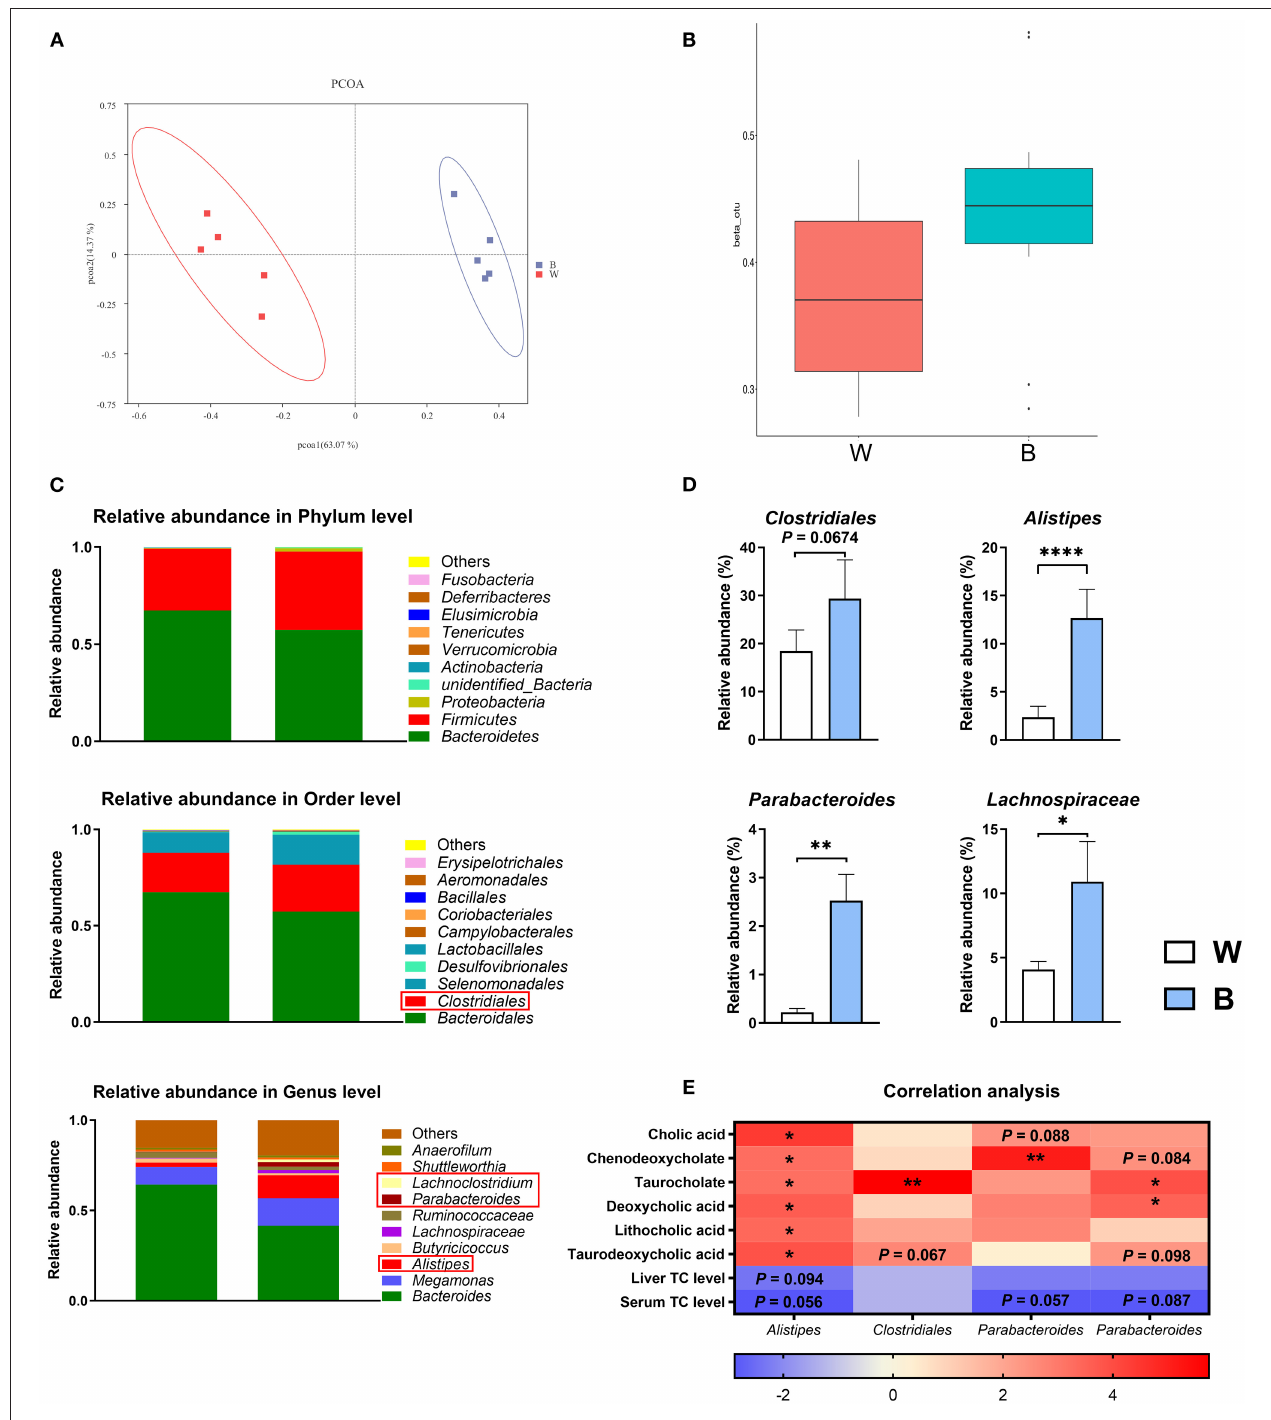
FIGURE 6 | Exposure to blue light alters the intestinal microbiota. (A) Principal component analysis of microbial communities in the cecum from the white-light and blue-light groups ( n = 6). (B) Beta diversity of microbial communities from the white-light and blue-light groups ( n = 6). (C) Relative abundance of bacteria at the phylum level. OTUs with an occurrence lower than 1% are not shown. Relative abundance of the top 10 orders in each group ( n = 6); Relative abundance of the top 10 genus in each group ( n = 6). (D) Effect of blue light on the relative abundance of Alistpes , Clostridiales , Parabacteroides , and Lachnospiraceae ( n = 6, mean with SEM). (E) Correlation analysis between microbiota and metabolites. Each row represents a different microorganism, and each column represents a different metabolite. Red indicates a positive correlation; blue indicates a negative correlation. Data in d were analyzed using the unpaired t -test, * P < 0.05, ** P < 0.01, **** P < 0.0001. Data in (E) were analyzed using the computer non-parametric Spearman correlation, * P < 0.05, ** P < 0.01.